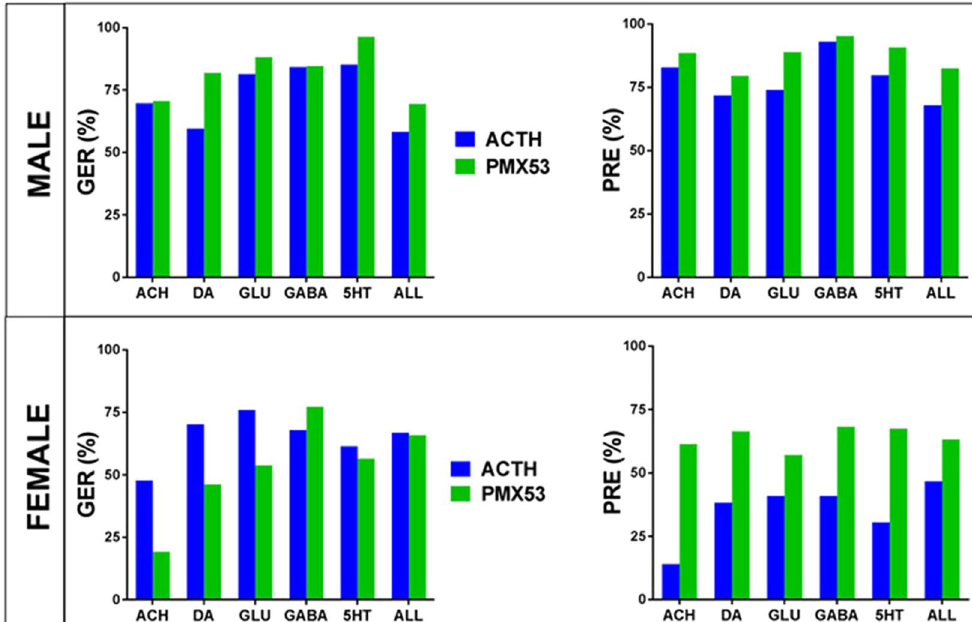
Figure 4. Recovery of gene expression following the two treatments in male and female rats with NMDA- induced spasms as quantified by the Gene Expression Recovery (GER) and Pathway Restoration Efficiency (PRE). Note that PRE indicates PMX53 is more efficient than ACTH for both